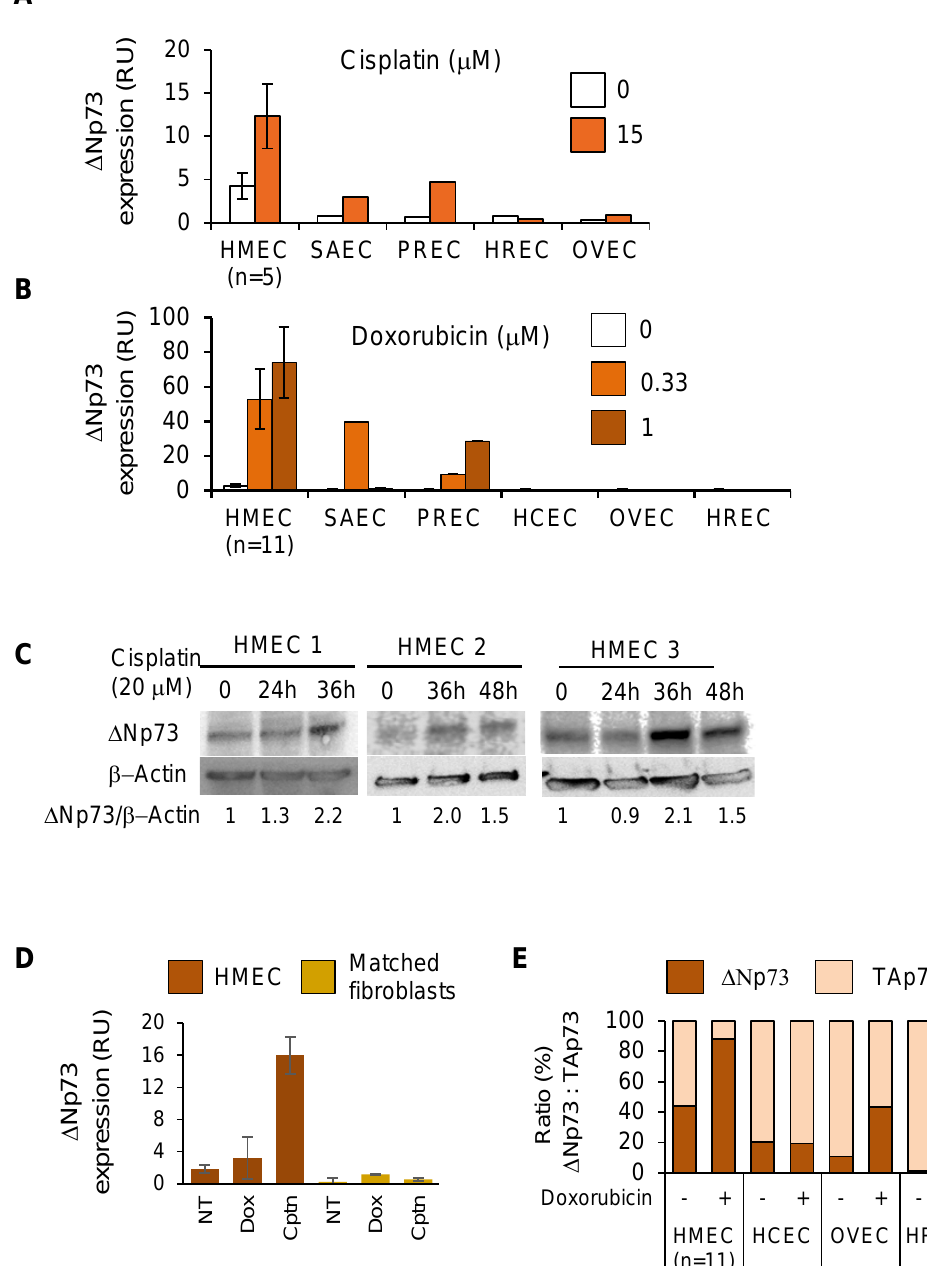
Figure 2. Tissue-specific induction of deltaNp73 by DNA damage in human epithelial cells. ( A ) Basal expression and induction of deltaNp73 (mRNA) following exposure to cisplatin or ( B ) doxorubicin for 24 h in HMECs as compared to other types of normal epithelial cells. ( C ) DeltaNp73 protein expression increased in HMECs from three individuals following exposure to cisplatin for the indicated time points. ( D ) DeltaNp73 expression (mRNA) in HMECs and in matched fibroblasts originated from the same breast tissue ( n = two individuals) following treatment with 0.33 µ M doxorubicin (doxo) or 20 µ M cisplatin (cptn) for 24 h. ( E ) The ratio of deltaNp73:TAp73 expression (mRNA) was greater in HMECs ( n = 11 individuals) as compared to other epithelial cells ( n = 1 individual) following induction with 1 µ M doxorubicin for 24 h. Epithelial cells: HMEC—mammary; SAEC—small airways; HREC—renal; PREC—prostate; OVEC—ovary; HCEC—colon. Gene expression (mRNA) was measured by RT-qPCR and normalized to mRNA expression of the housekeeping gene, GAPDH (RU = 2 ∆ CT × 10 4 ). Error bars represent S.E.M for n >